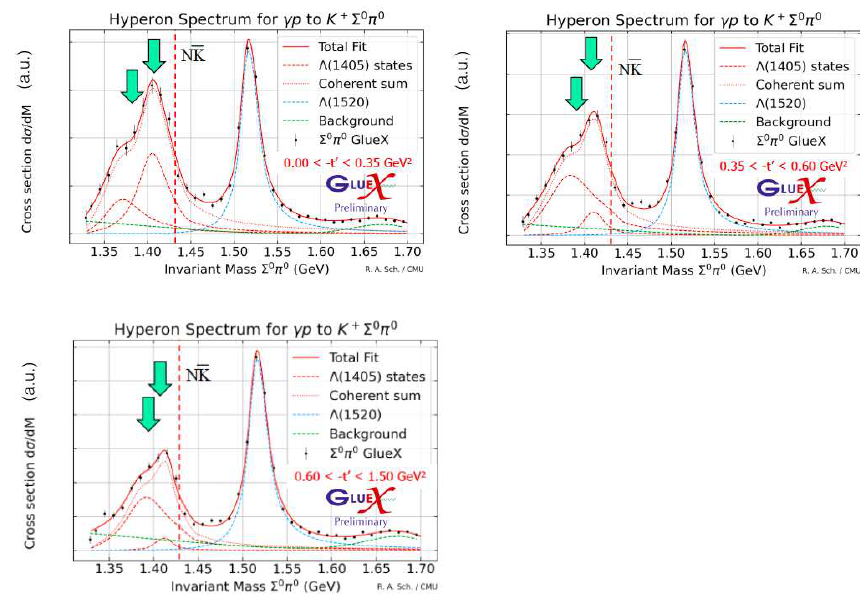
t min ) shown without a in three bins of ( t π 0 − −